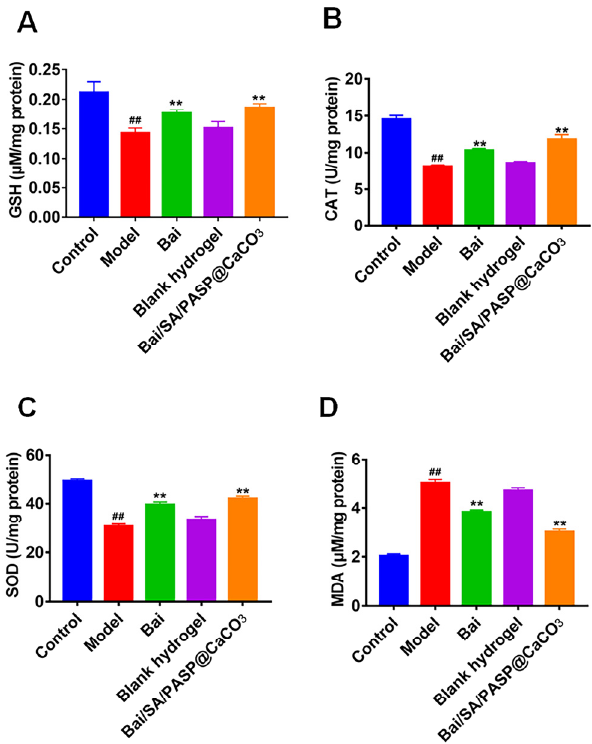
Figure 5. Effect of hydrogel on SOD ( A ), GSH ( B ), CAT ( C ), and MDA ( D ) activities in H 2 O 2 -induced GES-1 cell injury in vitro. Data are presented as mean ± SD ( n = 3). ## p < 0.01 vs. the control group, and ** p < 0.01 vs. the model group.